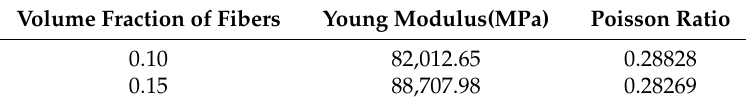
Table 6. Elastic properties of composites with two different volume fractions of fibers.